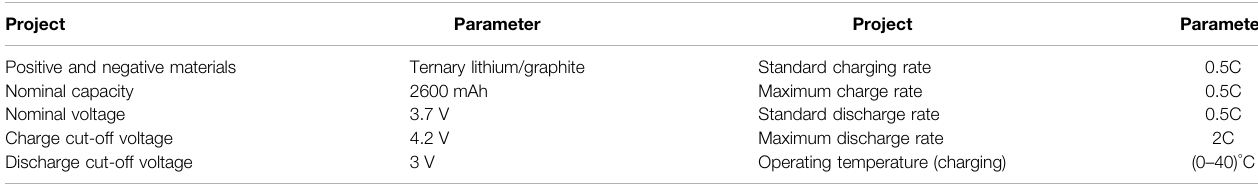
TABLE 1 | Parameters of domestic 18650